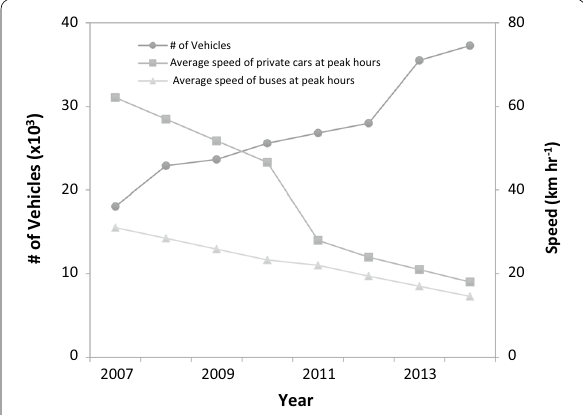
Fig. 6 Number of vehicles and average speed for private cars and buses at peak hours in Yangon, Myanmar. The number of vehicles doubled from 2007 to 2014. Meanwhile, average speed of buses and private cars at peak hours both decrease dramatically, leading to the speeds decreased to less than 1/2 or 1/3 of the 2007’s levels for buses and private